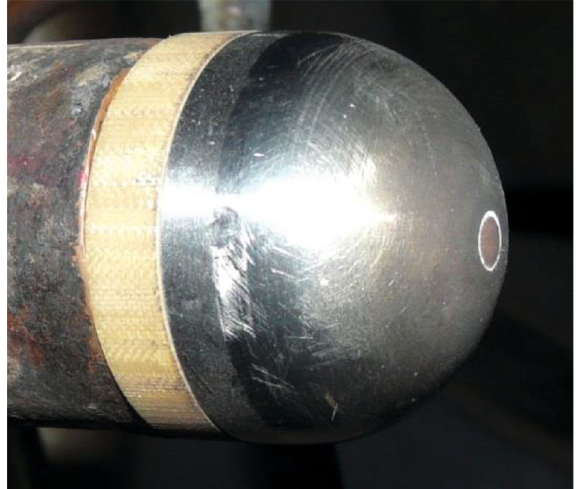
Figure 6: Spherical cylinder model.